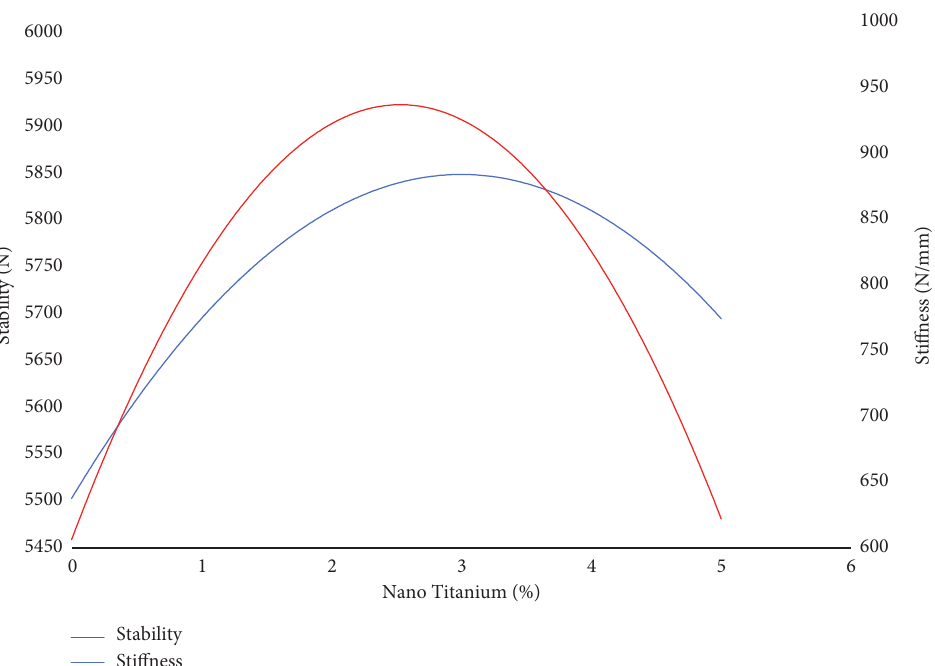
Figure 15: Stability and stiffness against nano TiO